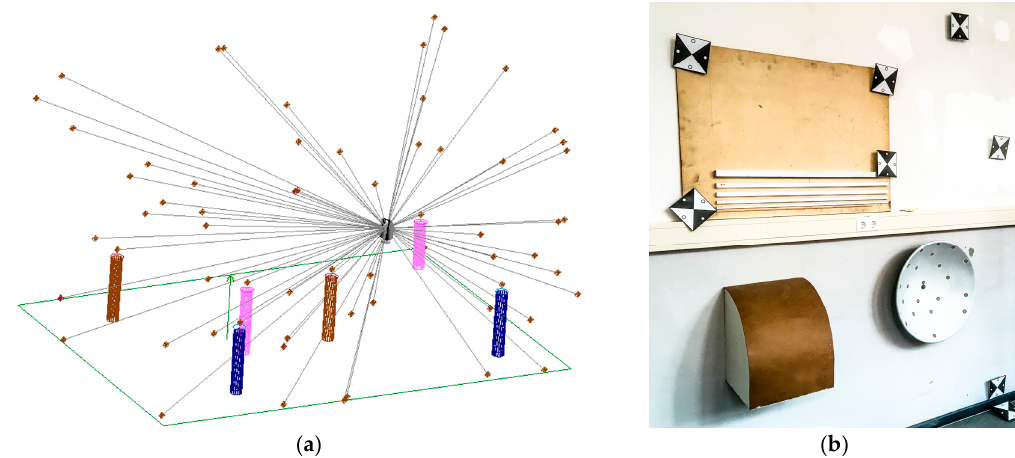
Figure 4. ( a ) Determination of the reference points coordinates with Spatial Analyzer for the visibility analysis; ( b ) reference geometries (cuboids, curved surface and paraboloid).